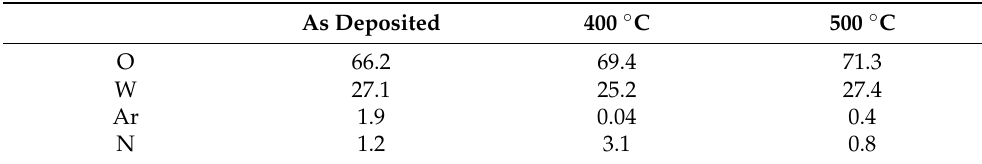
Table 1. Atomic composition of O, W, Ar, and N 2 in WO 3 thin films as deposited and annealed at 400 °C and 500 °C.